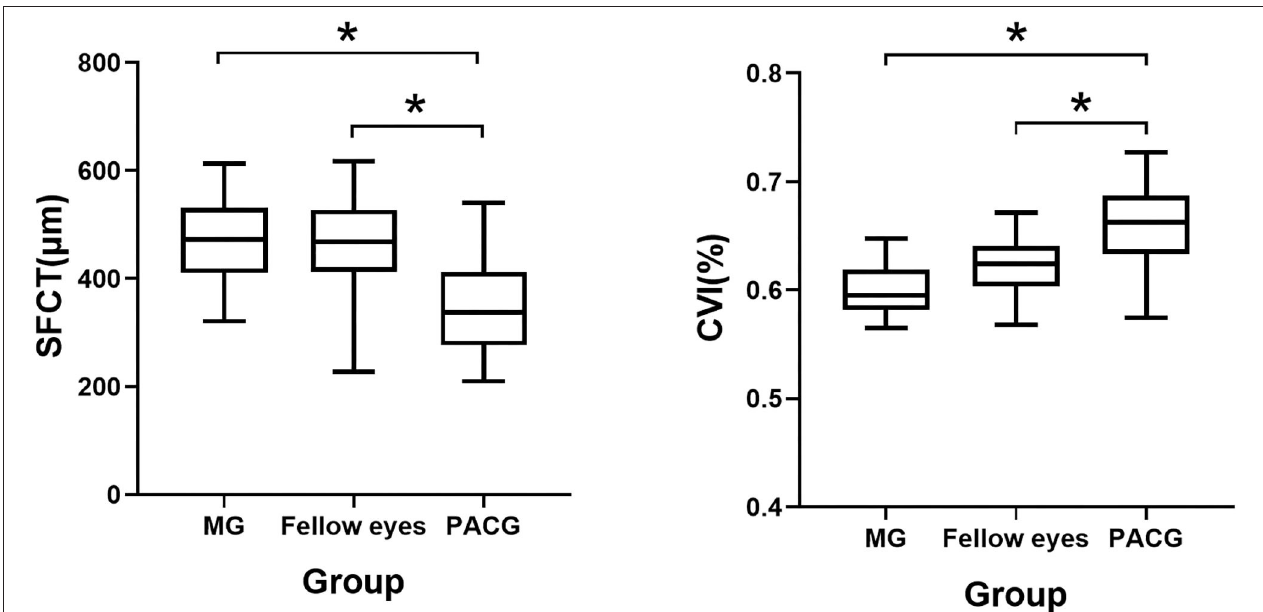
FIGURE 2 | Box chart representing measurements of the CVI and the SFCT across all the groups. * p < 0.05. Error bars denote 95% CIs.